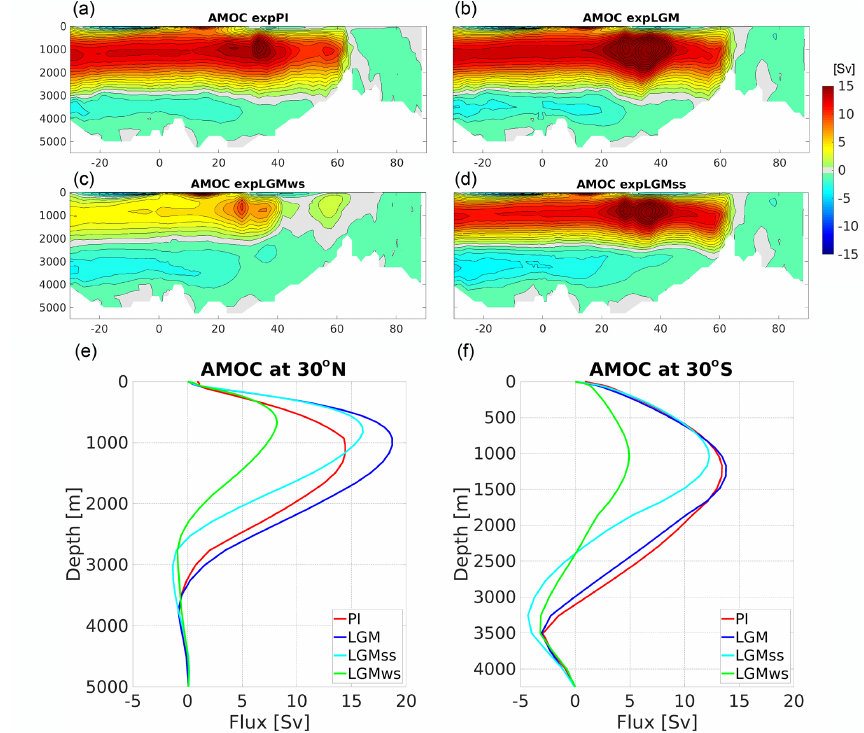
Figure 3. Simulated AMOC for the main experiments in this study (Sv): stream function for (a) expPI, (b) expLGM, (c) expLGMws, and (d) expLGMss. The vertical profiles of the AMOC (e) at 30 ◦ N and (f) at 30 ◦ S are also shown. The average states of the last 50 years are